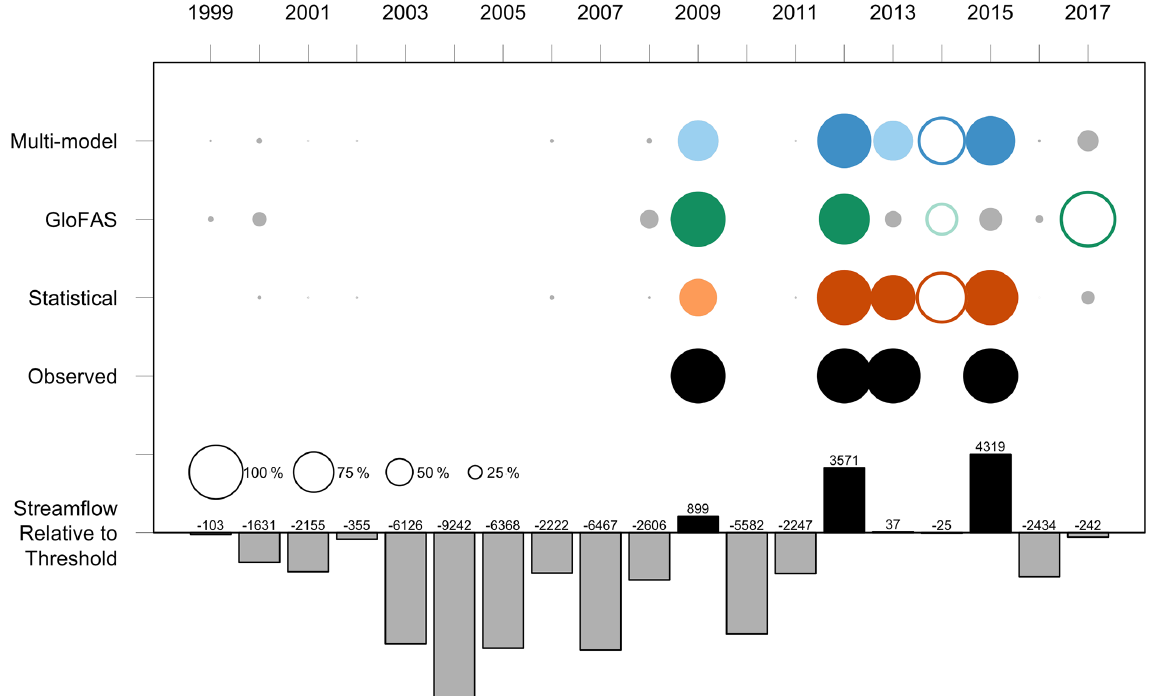
Figure 6. Marañón River at San Regis early actions triggered ( ≥ 75% probability of exceeding threshold) based on observed data (black) and season-ahead predictions from statistical model (orange), GloFAS (green), and multi-model (blue). Dark colors represent a ≥ 75% probability of threshold exceedance; light colors represent a 50%–75% probability of threshold exceedance; grey represents a < 50% probability of threshold exceedance. Open circles represent false positives. Circle sizes are scaled to probability of threshold exceedance. Black (grey) bars indicate relative magnitude of streamflow compared to the 80th percentile in cubic meters per second (m 3 s − 1 ).